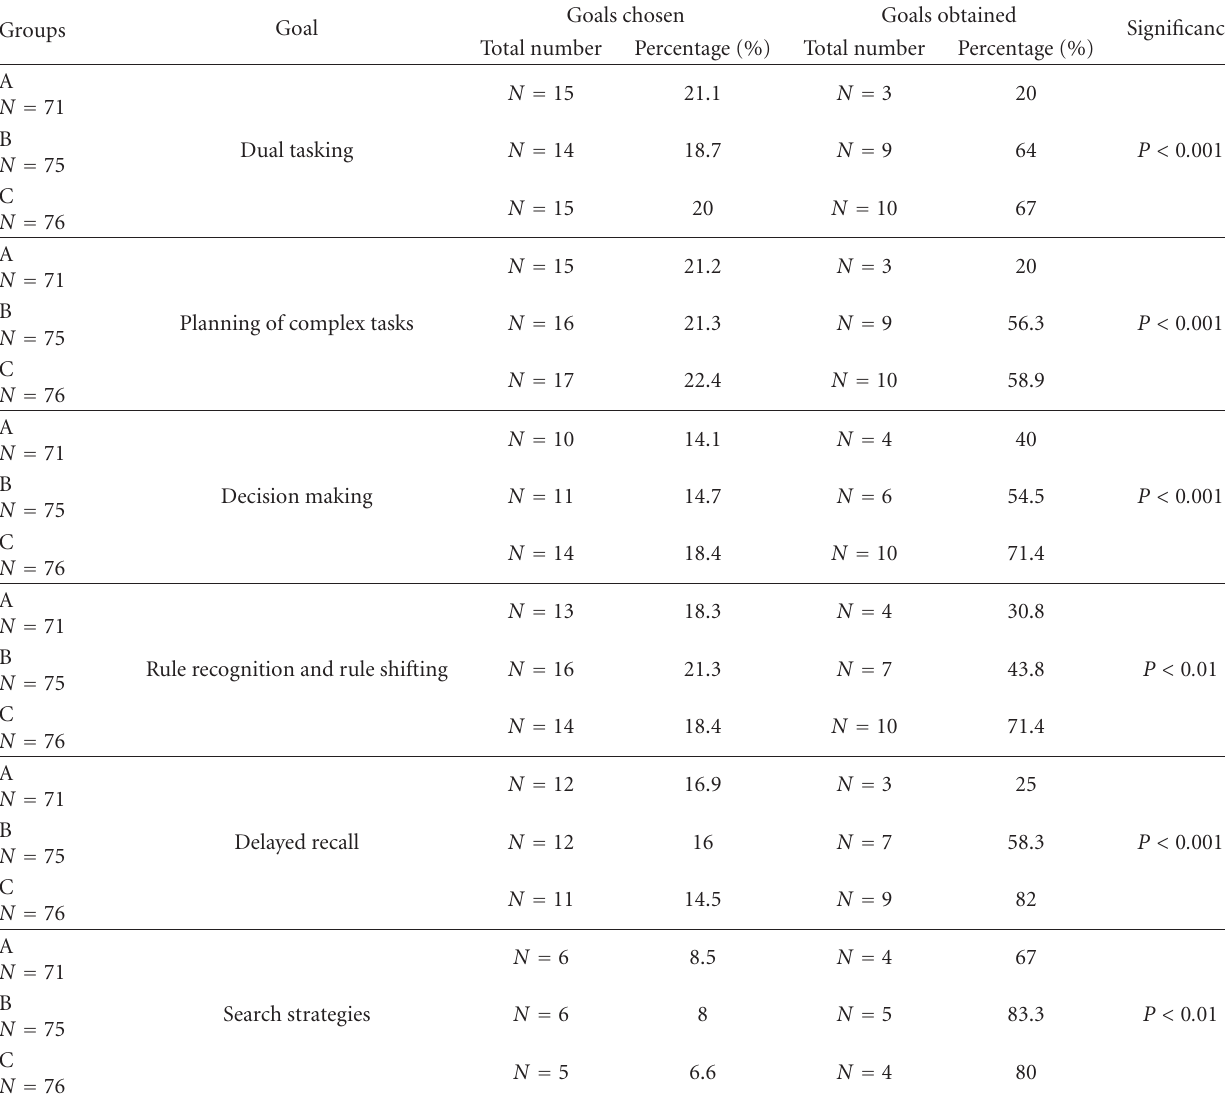
Table 7: Individual goals chosen by the patients and percentage of goal achievement.